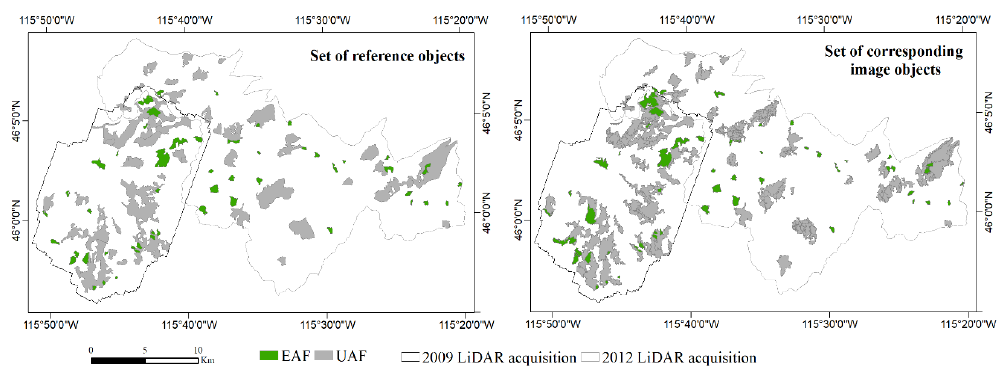
Figure 10. Validation dataset: Reference objects delineated through visual interpretation of NAIP imagery and LiDAR point clouds (left); and corresponding image objects of the optimal segmentation of the ‘H95′ LiDAR metric (right). Even-aged forest stand (EAF) reference objects and their corresponding image objects are shown in green, and uneven-aged forest stand (UAF) reference objects and their corresponding image objects are shown in gray. A total of 100 reference objects were generated through visual interpretation of NAIP imagery and LiDAR point clouds: 25 EAF (average area: ~23 ha) and 25 UAF (average area: ~158 ha) on each LiDAR dataset.